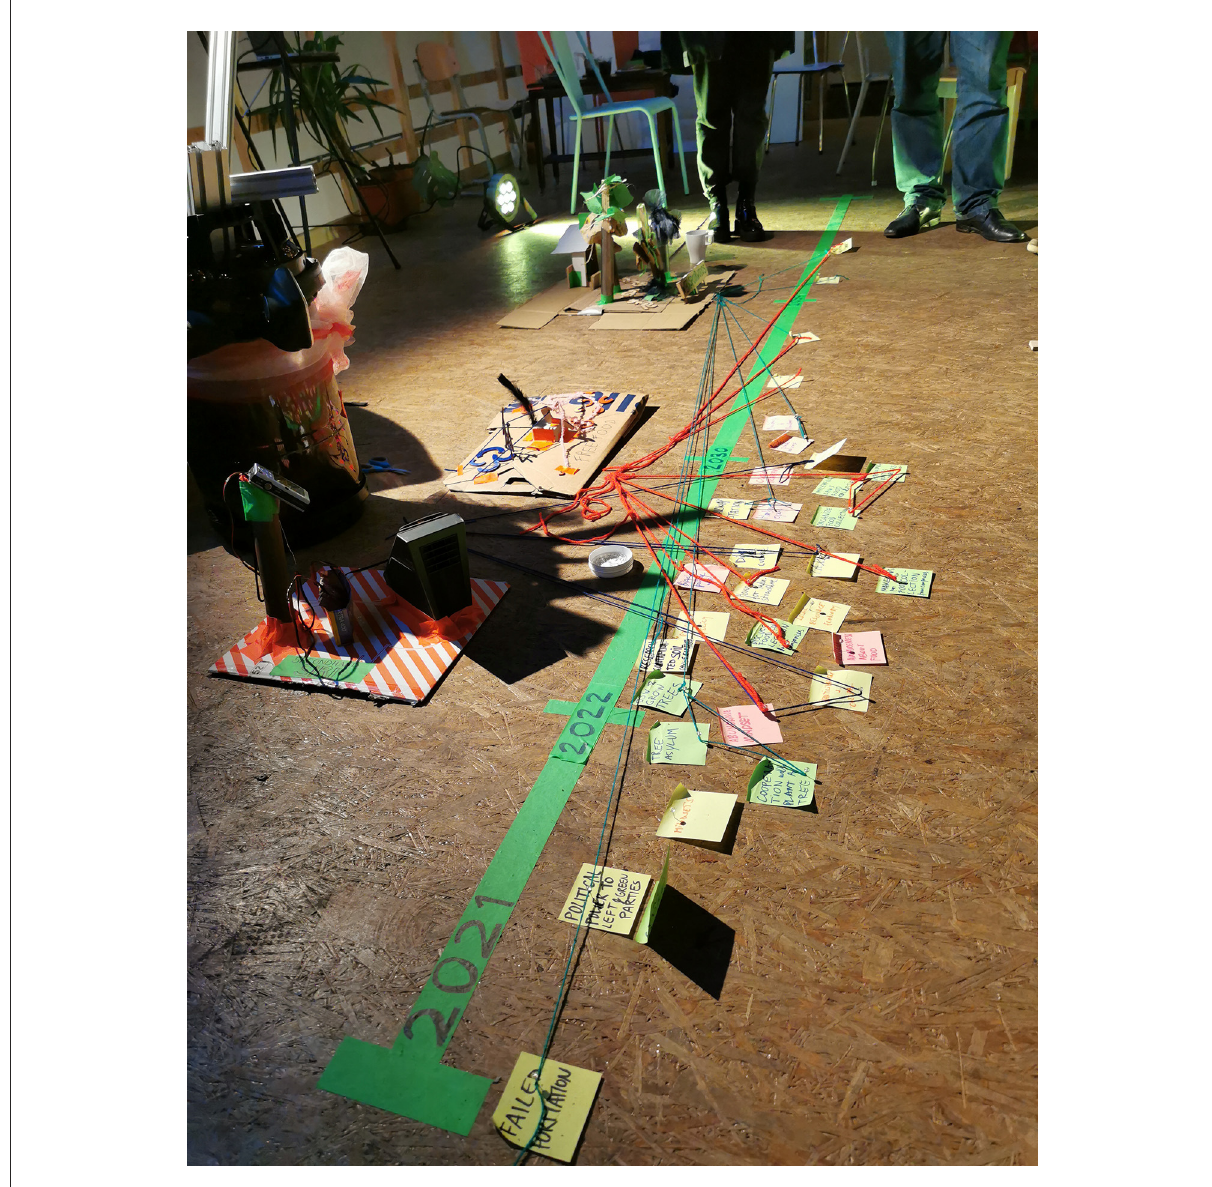
FIGURE10 Speculative objects planted on the timeline with rooting